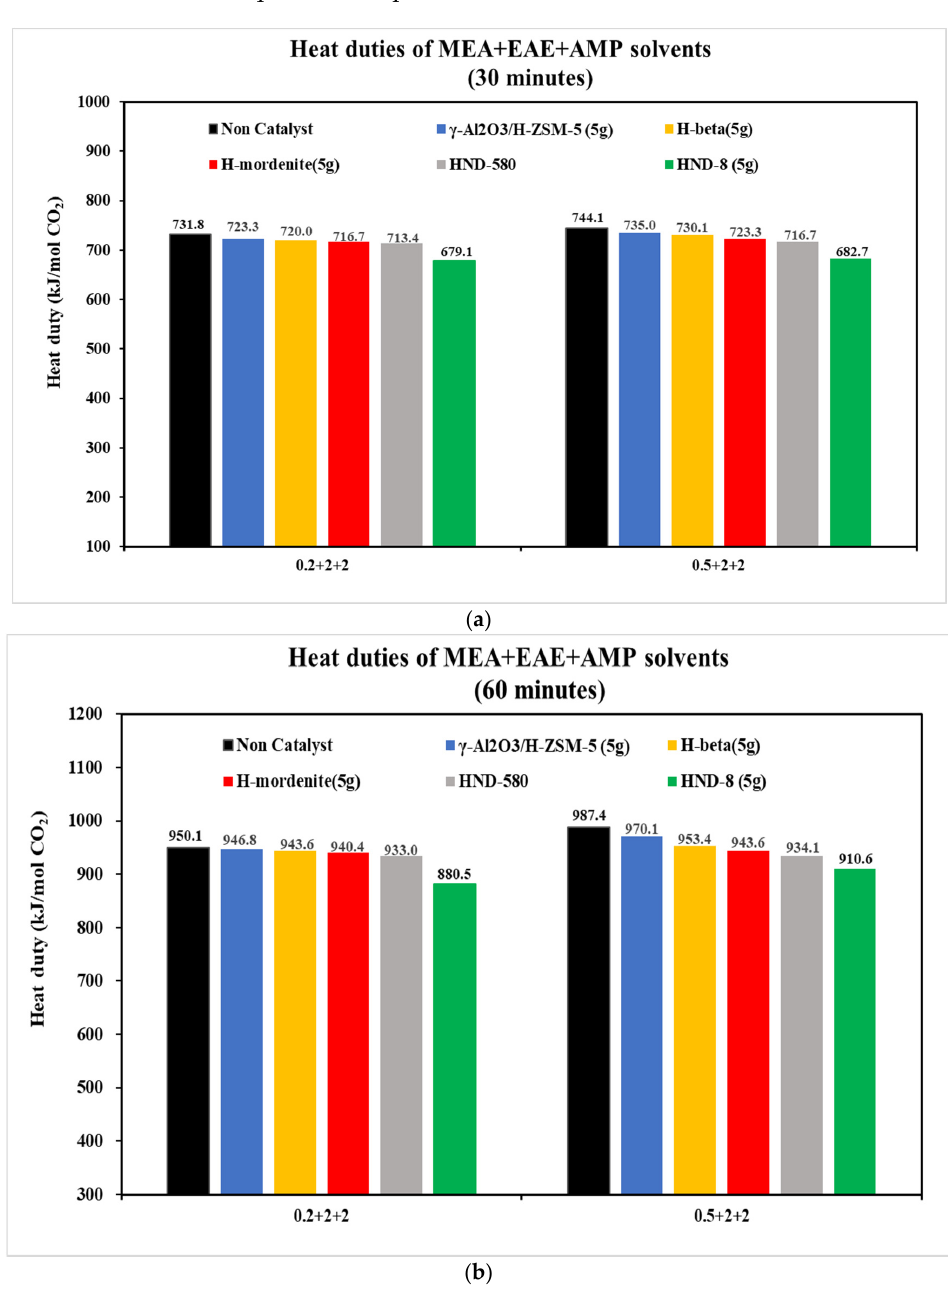
Figure 6. The heat duties of MEA + EAE + AMP with various catalysts at ( a ) 30 min and ( b ) 60 min. The desorption factors of 0.2 + 2 + 2 and 0.5 + 2 + 2 mol/L were categorized in Table 3. Among five commercial catalysts, HND-8 was the best, and the factors of 0.2 + 2 + 2 and 0.5 + 2 + 2 mol/L were comparable with each other using the TP method. The desorption factor should take heat duty, average desorption rate and cyclic capacity into consideration. The HD of 0.5 + 2 + 2 mol/L was slightly lower than that of 0.2 + 2 + 2 mol/L, and the AD of 0.5 + 2 + 2 mol/L was slightly higher than that of 0.2 + 2 + 2 mol/L because of its slightly higher amine concentration with catalysts. After calculation, the desorption factors for the two cases were very close to each other. Both combinations were applicable